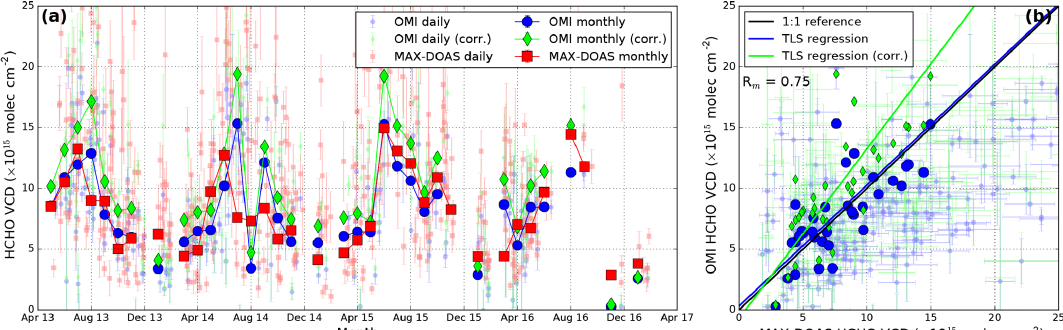
Figure 5. (a) Time series of the MAX-DOAS (red markers) and OMI (blue markers) HCHO VCDs over Nanjing from 2013 to 2017. MAX- DOAS data are temporally averaged around the OMI overpass time. OMI measurements are spatially averaged for pixels within 20km of the MAX-DOAS measurement site. OMI NO 2 VCDs retrieved using MAX-DOAS profile as a priori information are indicated as green markers. (b) Comparison of HCHO VCDs between the MAX-DOAS and OMI satellite observations. The total least squares regression line is calculated based on the monthly average